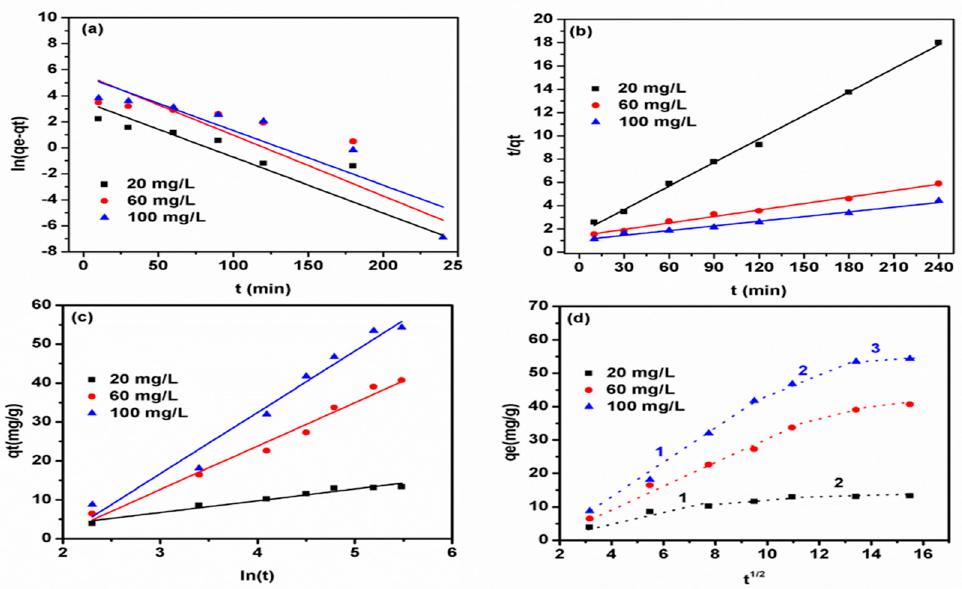
Figure 6. ( a – b ) Linear plots of the pseudo-first and second-order model and ( c – d ) the elovich